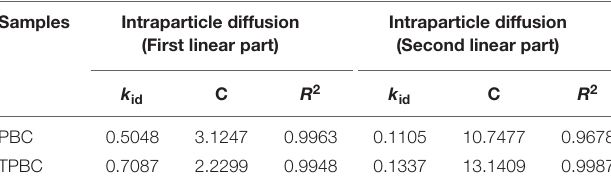
TABLE 3 | Kinetic parameters of intraparticle diffusion for the TC